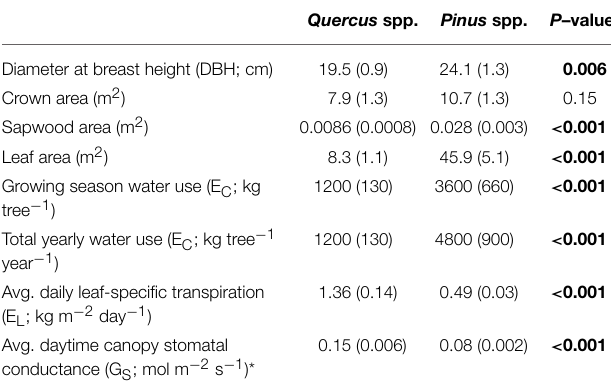
TABLE 2 | Means and standard error (in parentheses) of morphological and canopy-level water use properties for individual oaks and pines averaged across all years and study